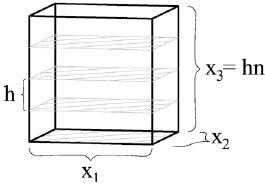
Fig. 2. Simplified model of internal volume of a building: x 1 – length; x 2 – width; x 3 – height; h – storey height; n – number of